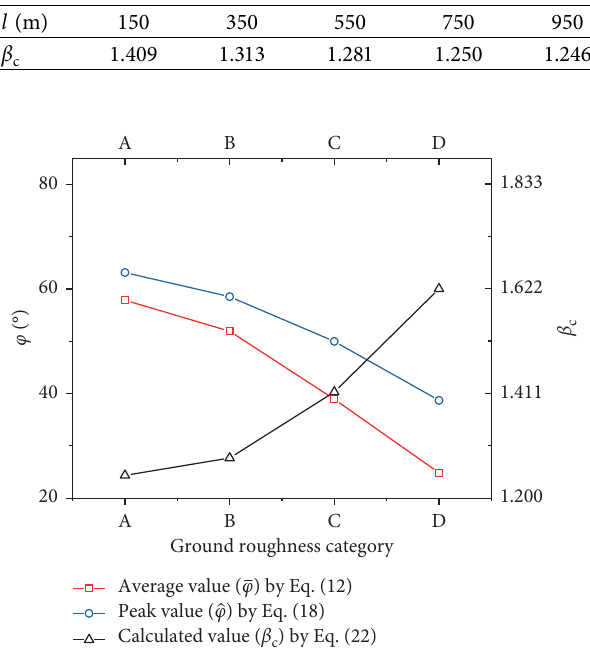
Figure 9: Influence of sag-to-span ratio ( η ) on the windage yaw angle ( φ ).